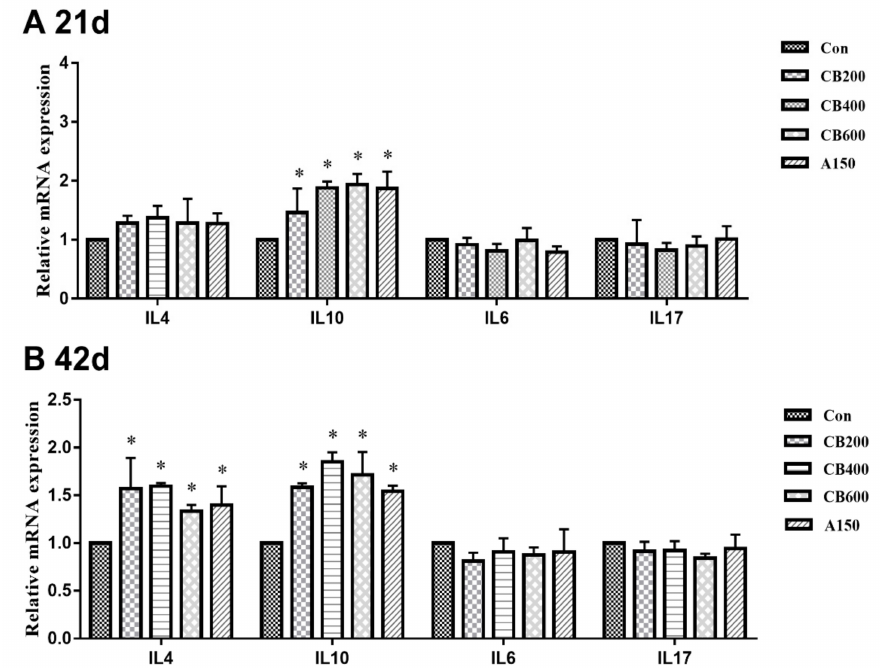
Figure 4. Effects of C. butyricum and aureomycin on relative mRNA expression of inflammatory cytokine genes of intestine in Pekin ducks (N = 10 replicates per group). ( A ) The relative mRNA expression of inflammatory cytokine genes at 21 d; ( B ) The relative mRNA expression of inflammatory cytokine genes at 42 d. The superscript * indicate that there are significant differences ( p < 0.05) compared with the control group. Con, group Con; CB200, group CB200; CB400, group CB400; CB600, group CB600; A150, group